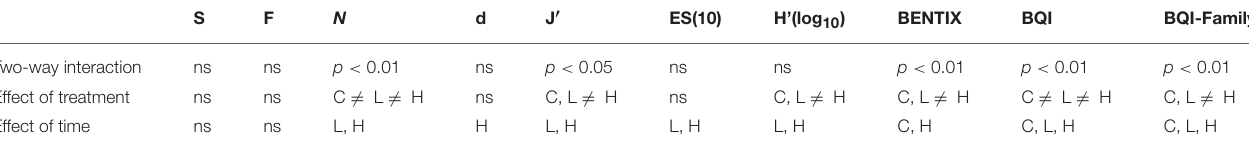
TABLE 2 | Summary of two-way repeated measures analysis of variance results and post-hoc analysis of diversity and ES